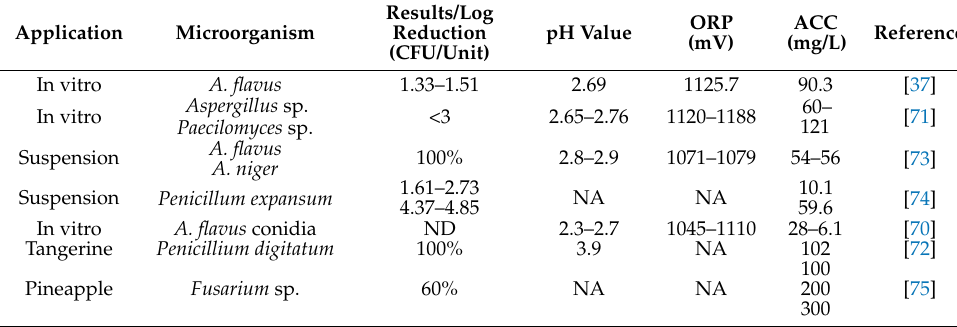
Table 7. Summary of AEW and WAEW antifungal